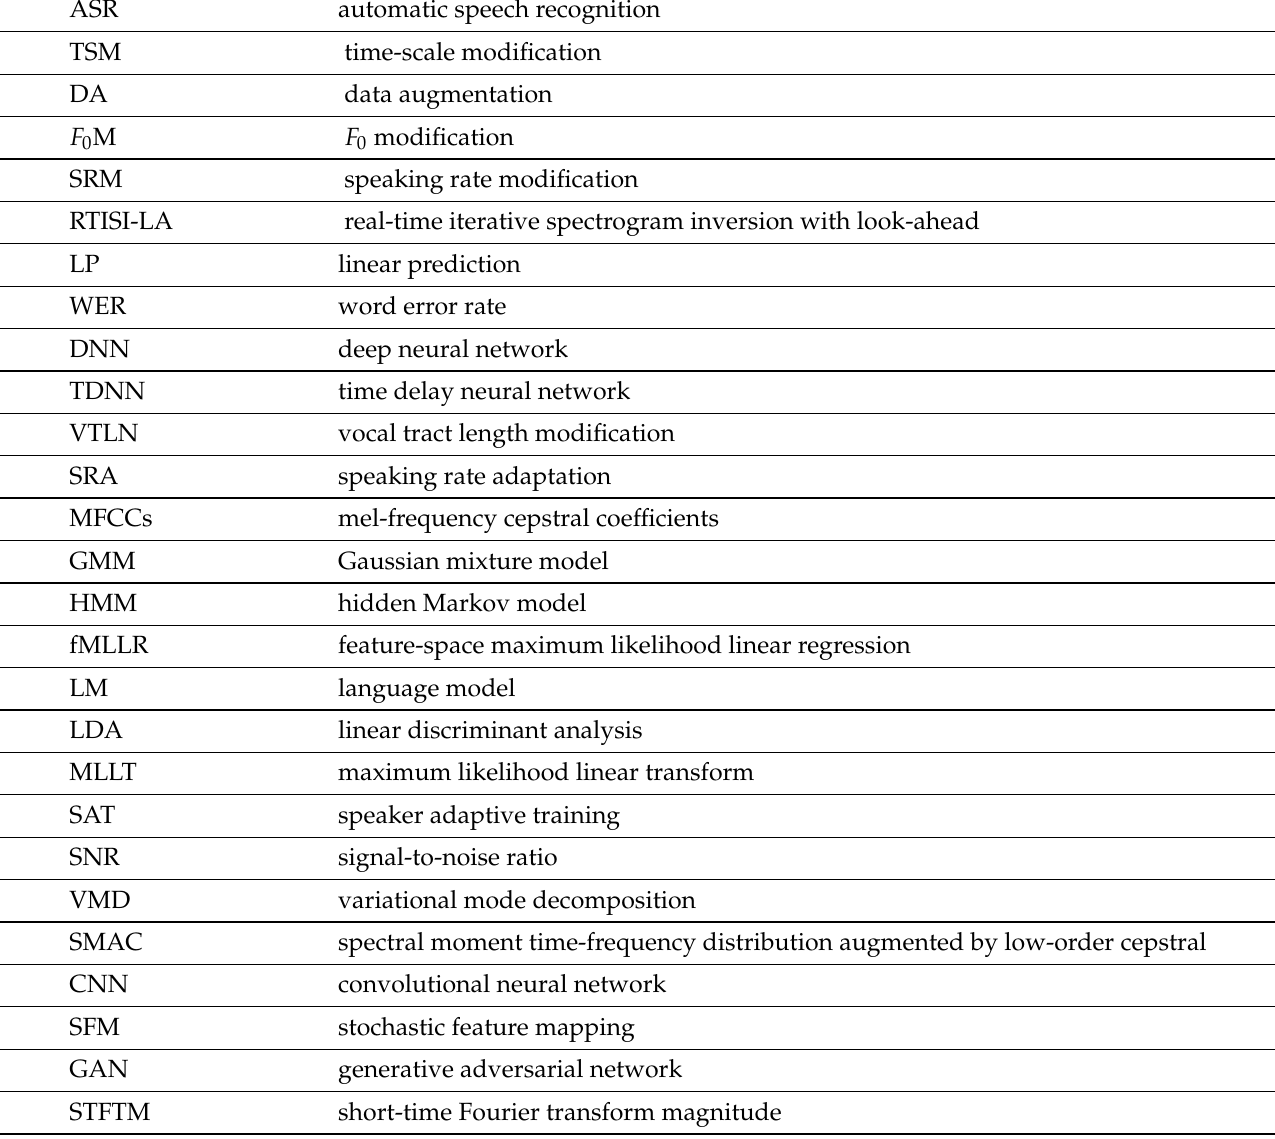
Table 1. List of